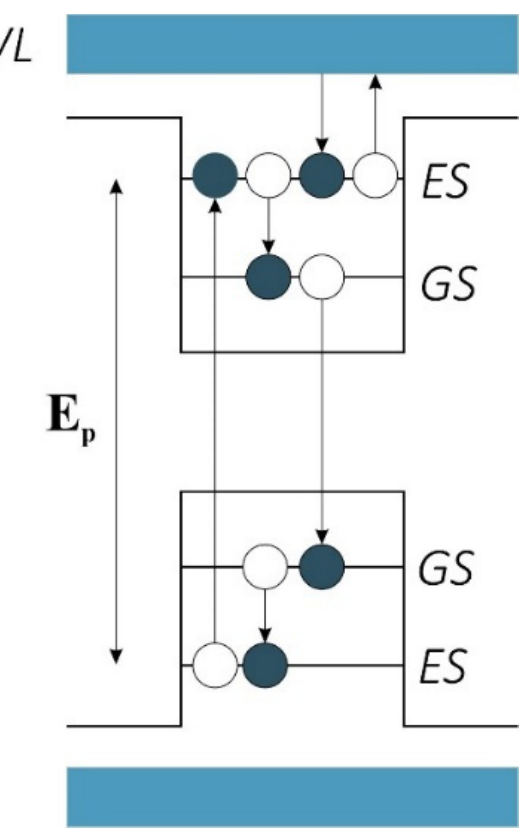
Figure 6. Transitions between the eigenstates.